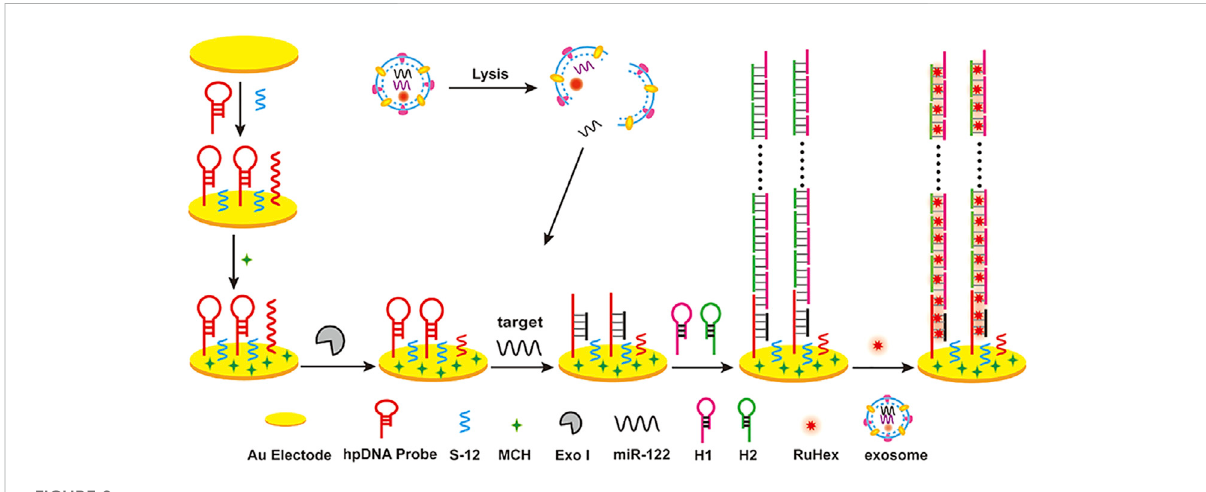
FIGURE 9 Exosomal miRNA detection by an electrochemical sensing platform harnessing HCR as a signal ampli fi cation strategy. Reprinted with permission from Guo et al.